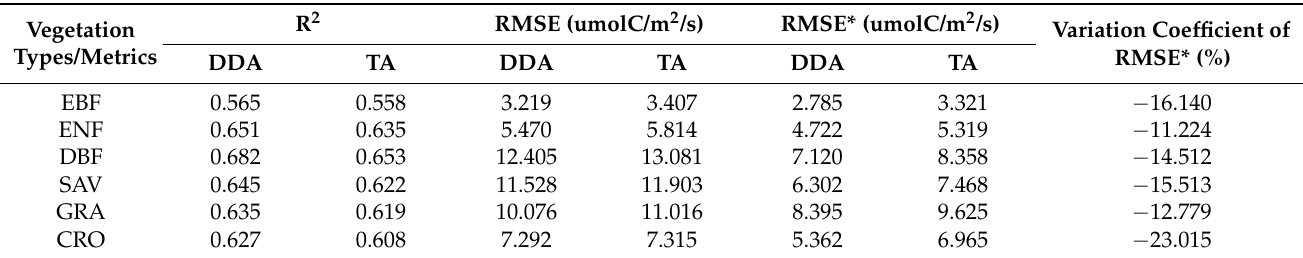
Table 6. The statistic metrics of DDA-based GPP (left side) and TA-based GPP (right side) with observed